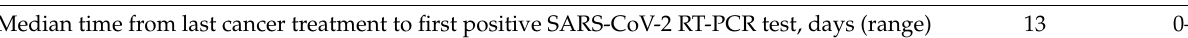
Routine or contact tracing screening of asymptomatic